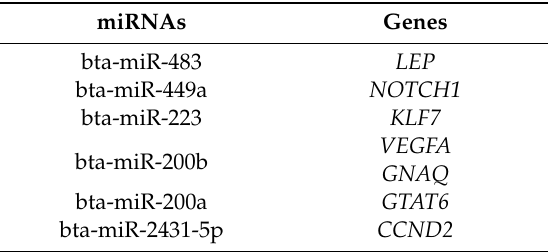
Table 8. Reproduction-related target genes for di ff erentially expressed